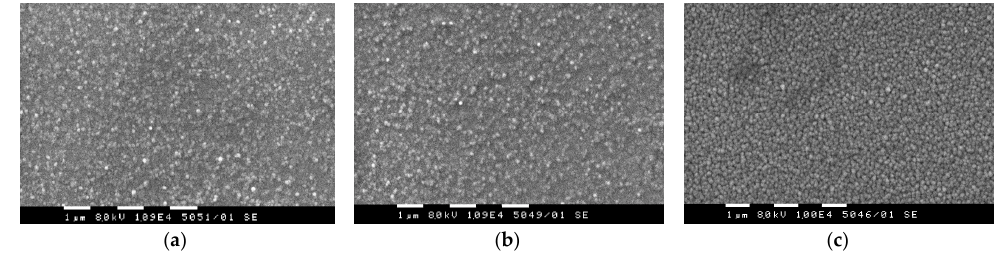
Figure 2. SEM images of ZGO films sputtered at: ( a ) 0.5 kV; ( b ) 0.9 kV; ( c ) 1.1 kV. AFM topographies of the ZGO thin films as a function of the sputtering voltage are shown in Figure 3a–c. Figure